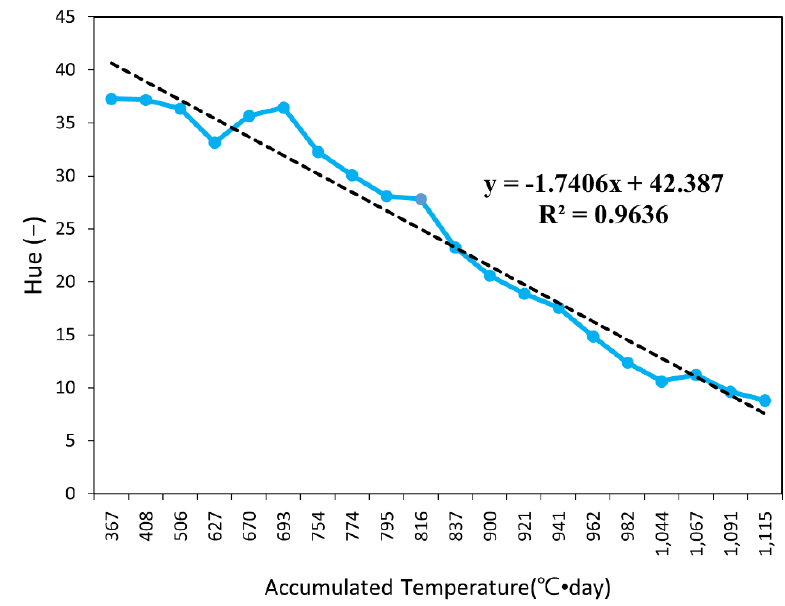
Figure 9. The change in hue color model at different accumulated temperatures. Using our temperature–hue data, we divided the maturity into six levels. The point at which the hue value became lower was set as the “green” standard. The “red” standard was set at the point at which the hue stopped changing and the accumulated temperature reached about 1100 ◦ C per day. Then, the range was divided into four sections. Figure 10 shows the relationship between the hue color model and the maturity levels for tomato fruits, and image-based maturity standard for tomato fruits was defined by this